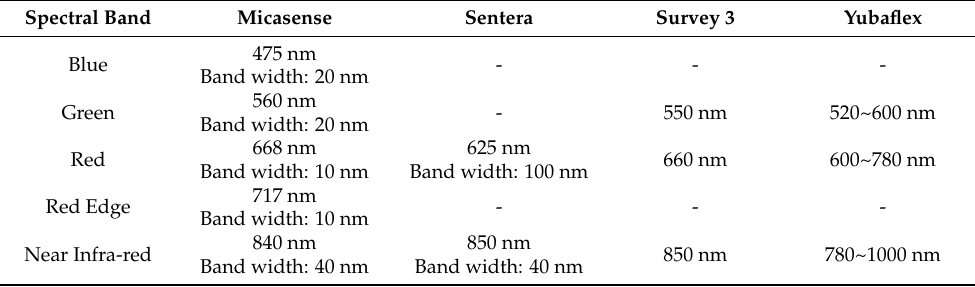
Table 3. Spectral wavelength band specification of each